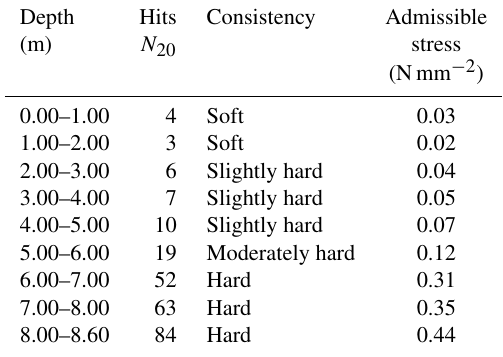
Table 2. Summary chart of the characteristics of the soil analysed at the Geolen S.A. laboratory: ϕ is the angle of internal friction, c is the cohesion, γ Sat is the saturated specific gravity and γ a is the apparent specific gravity.